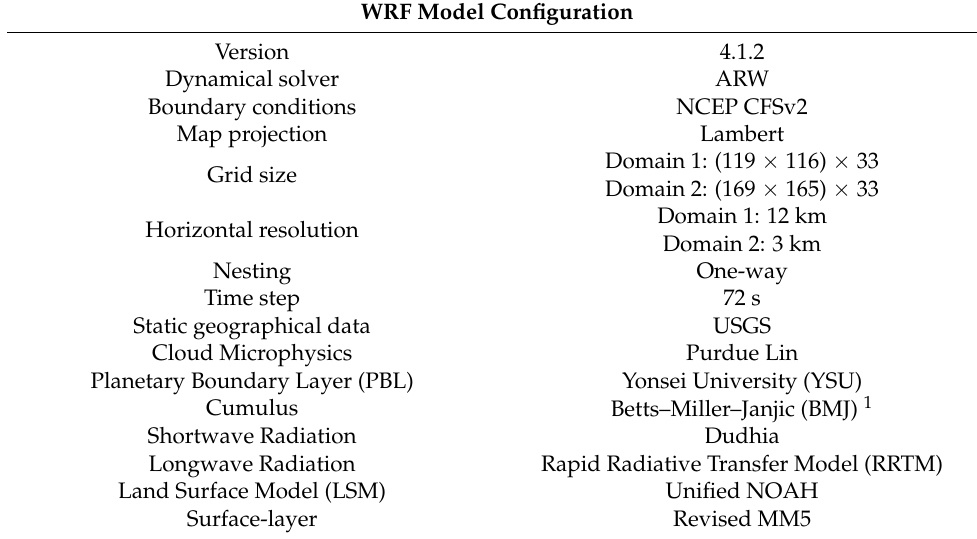
Table 2. Overview of WRF model